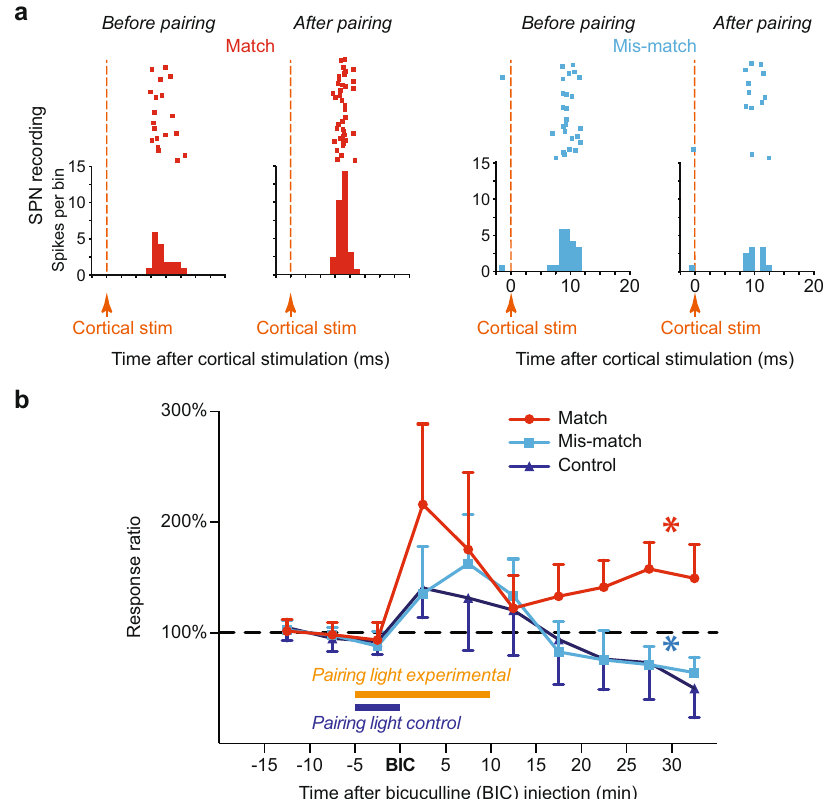
Fig. 2 SPN spikes induced by cortical stimulation were potentiated by coincident ChI pause, dopamine activation and depolarisation. a Cortical stimulation induced spike activity in SPNs. A representative potentiation (left) and depression (right) in SPNs 30 min after match or mismatch pairings, respectively. b Spike activity in SPNs (mean ± S.E.M.) was potentiated when the light-induced dopamine signal was coincident with ChI pauses (red, p = 0.0227), but not when coincident with excitation of ChIs (light blue, p = 0.0349) or when phasic dopamine was absent (dark blue — no light fl ashes after BIC, p = 0. 2219). N = 6 neurons in each group, * p < 0.05 (two-tailed paired t test; averaged last 10 min compared to